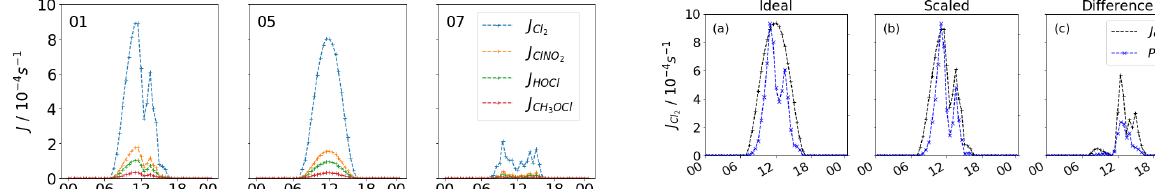
Figure 4. Transmission scaled J values for Cl 2 , ClNO 2 and HOCl for 1, 5 and 7 November, where 1 November had high photoly- sis rates in the morning that were reduced during the afternoon, 5 November is the closest to a full day’s ideal photolysis and 7 November shows very weak photolysis.